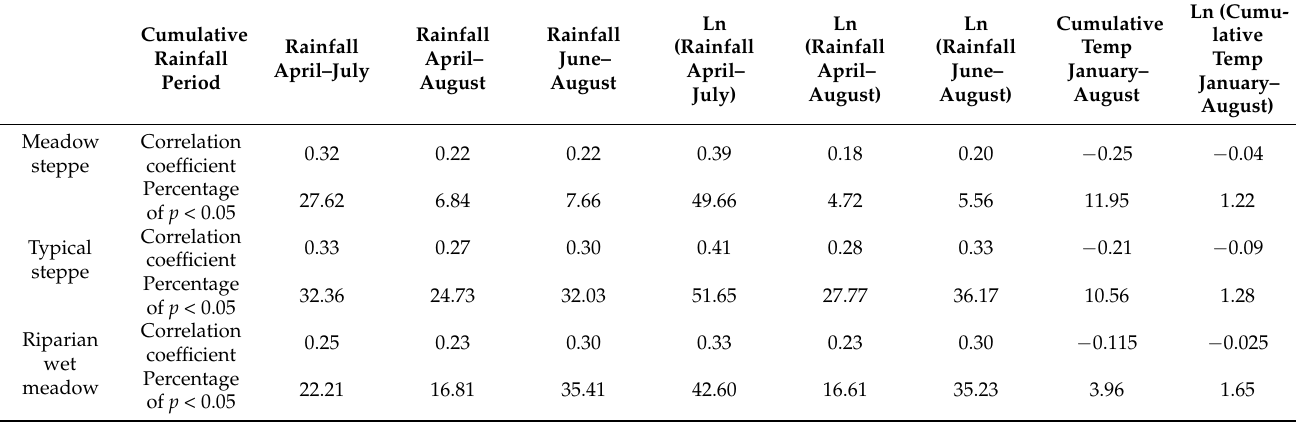
Table 1. Correlation coefficient of NDVI with precipitation and temperature in three ecosystems, with significant area ( p < 0.05) as a percentage of this